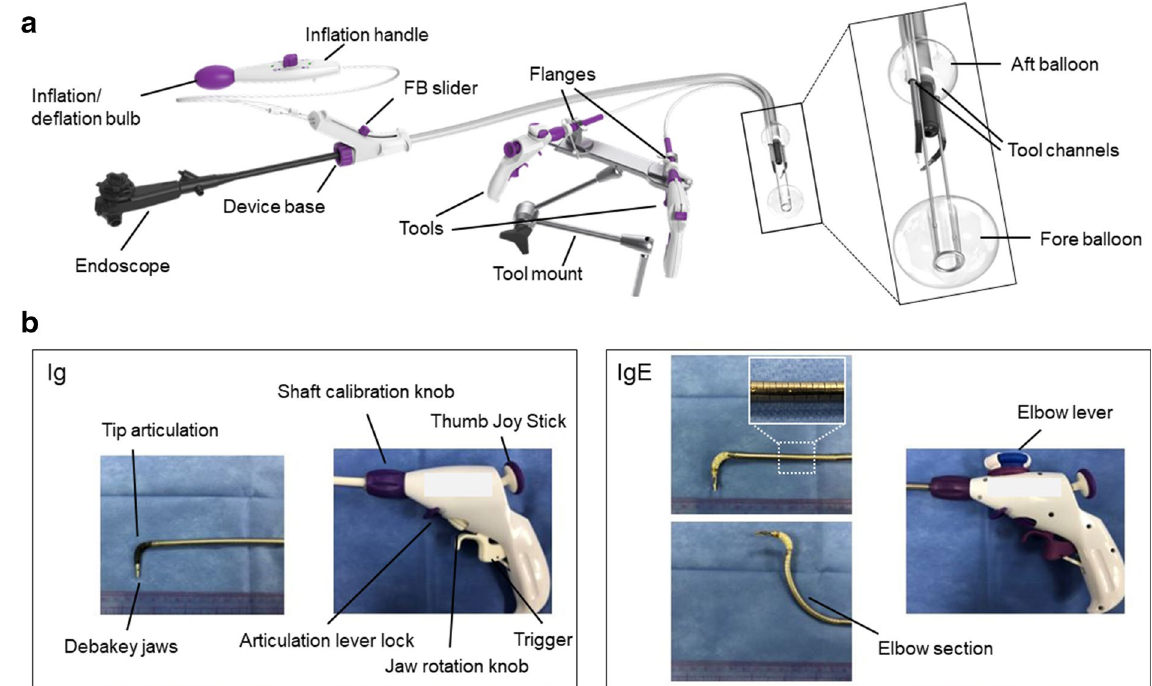
Figure 1. Traction devices. ( a ) Double-balloon Endolumenal Surgical platform, DESP. ( b ) Endolumenal Interventional Grasper, Ig/ Endolumenal Interventional Grasper with Elbow,